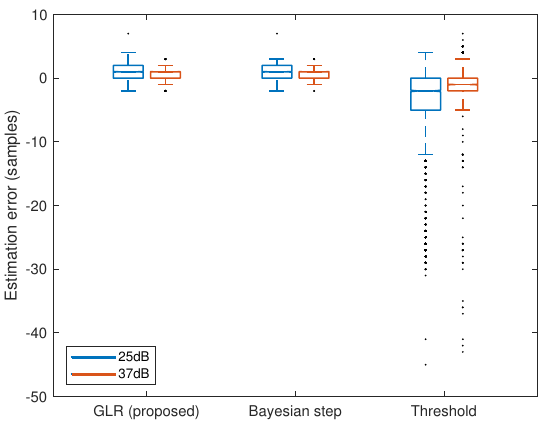
Figure 11. Boxplots of the estimation errors for two different average SNR values. The line in the center of a box is the median; the box edges indicate the 25th and 75th percentiles; the whiskers represent the lowest and highest values without considering outliers; the outliers are represented by the point “ · ” marker